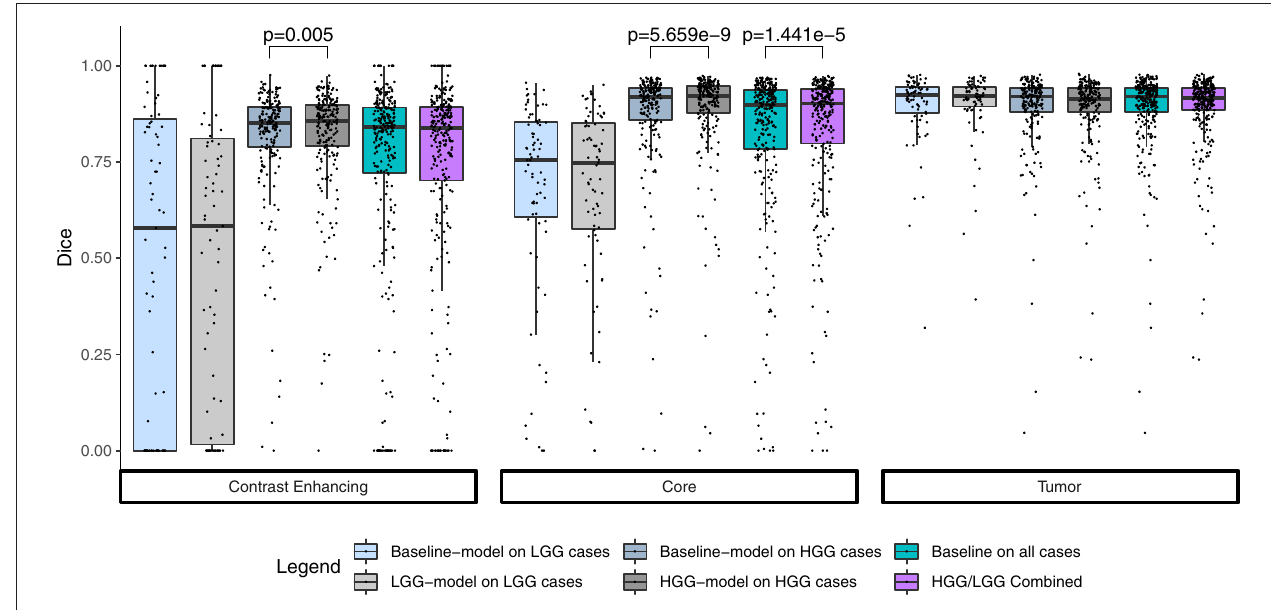
FIGURE 1 | Summary statistics for the segmentation of the three compartments by means of a Tukey boxplot. p -values indicate statistically significant ( p < 0.05) improvements determined by a one-sided Wilcoxon signed rank test.